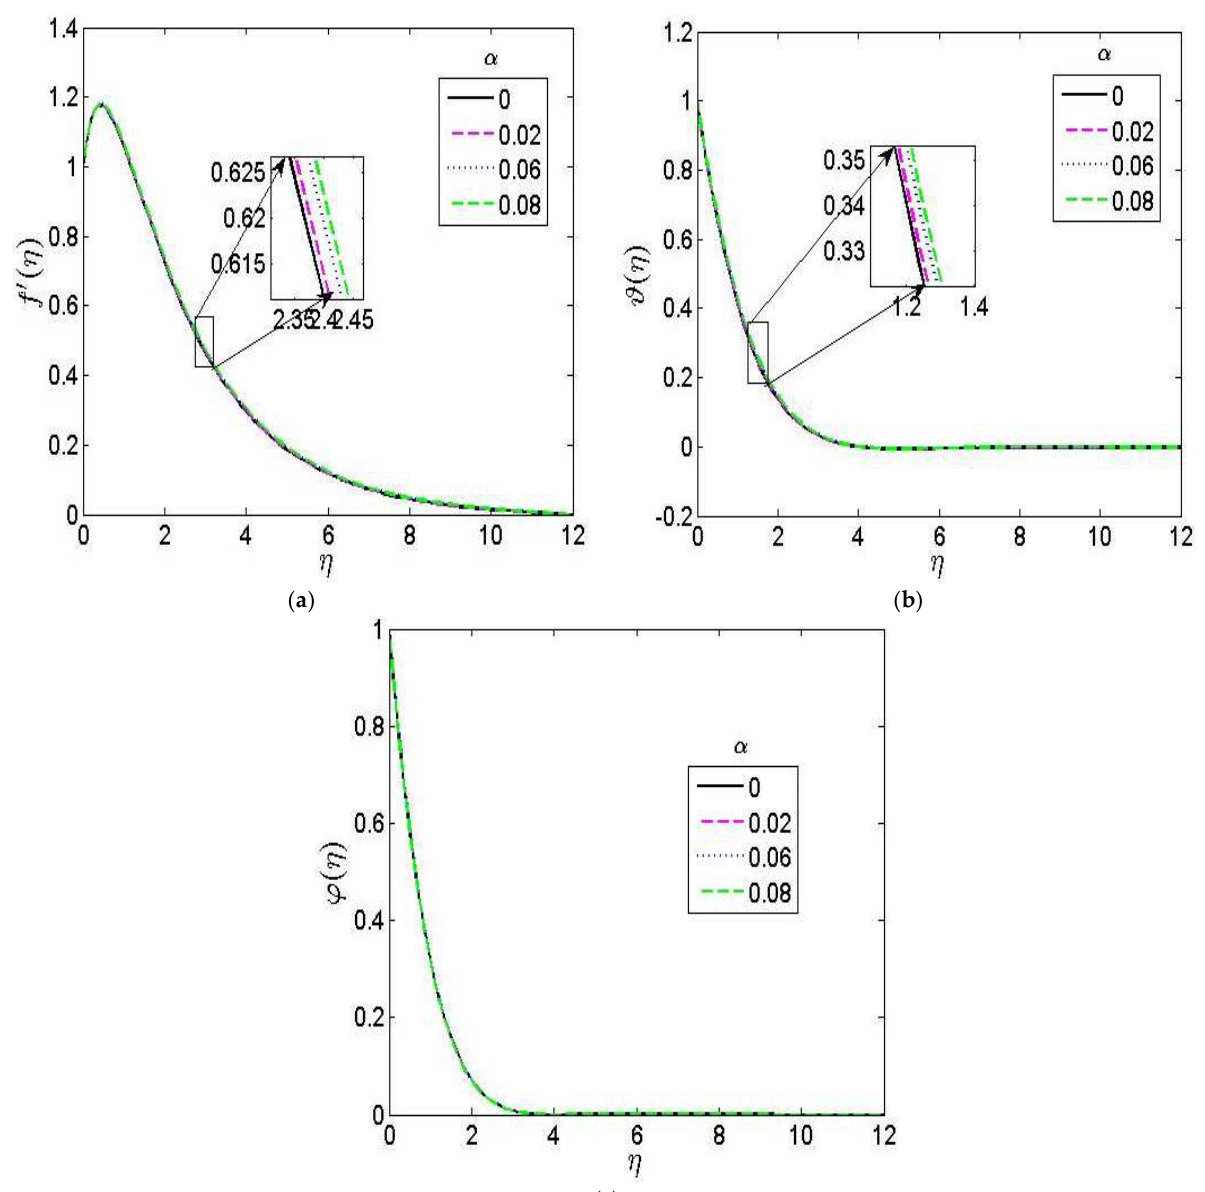
Figure 11. Effect of heat generation parameter α on ( a ) velocity, ( b ) temperature, and ( c ) concentration profiles.